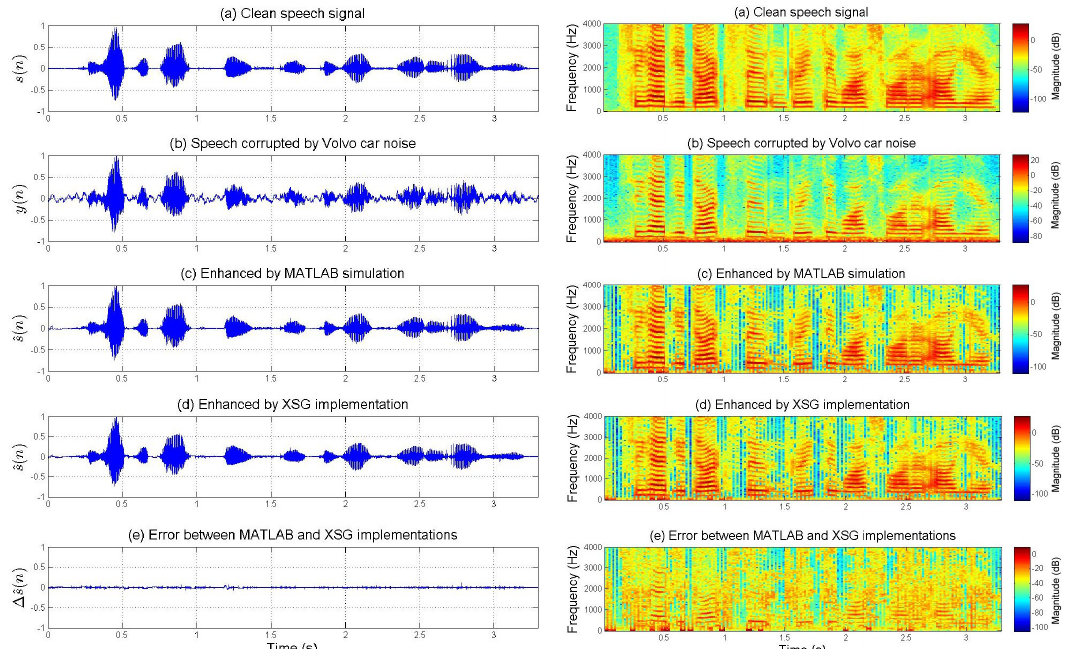
Figure 6. As in Figure 4 but for Volvo car